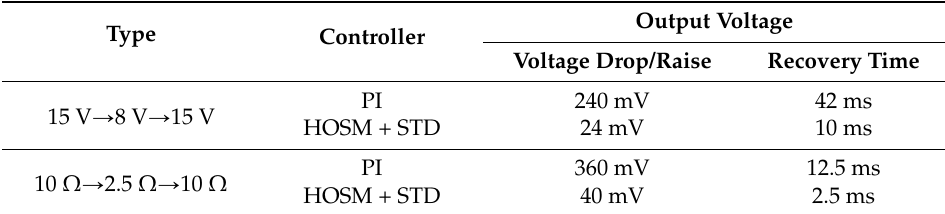
Table 6. Disturbance analysis results.